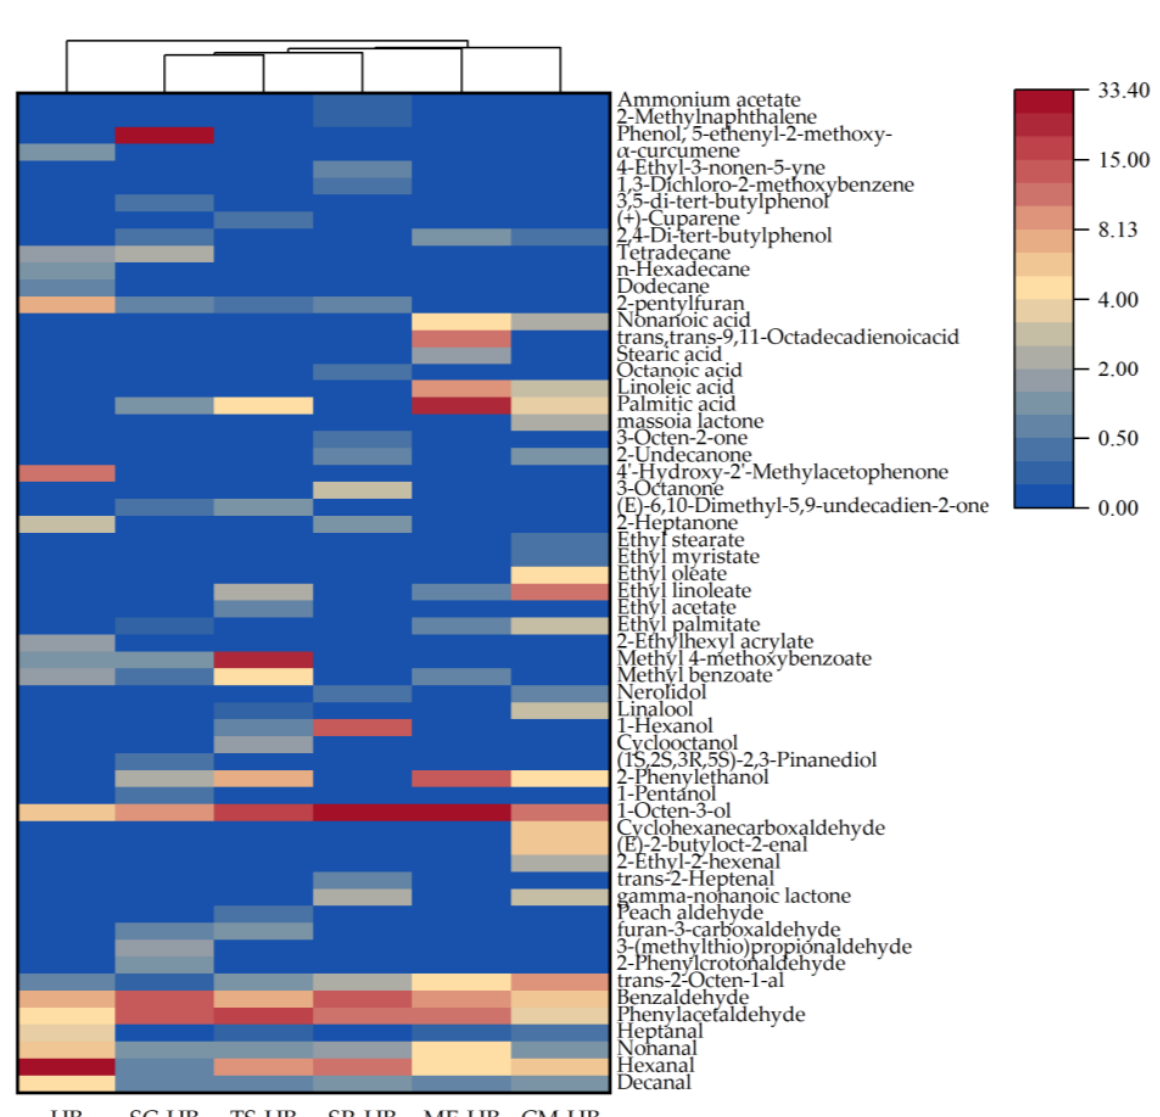
Figure 4. Thermogram analysis of volatile flavor compounds for original and fermented highland barley samples: HB (original highland barley), CM-HB (fermented highland barley with C. militaris ), SR-HB (fermented highland barley with S. rugoso-annulata ), ME-HB (fermented highland barley with M. esculenta ), SC-HB (fermented highland barley with S. commune ), TS-HB (fermented highland barley with T. sanguinea ).